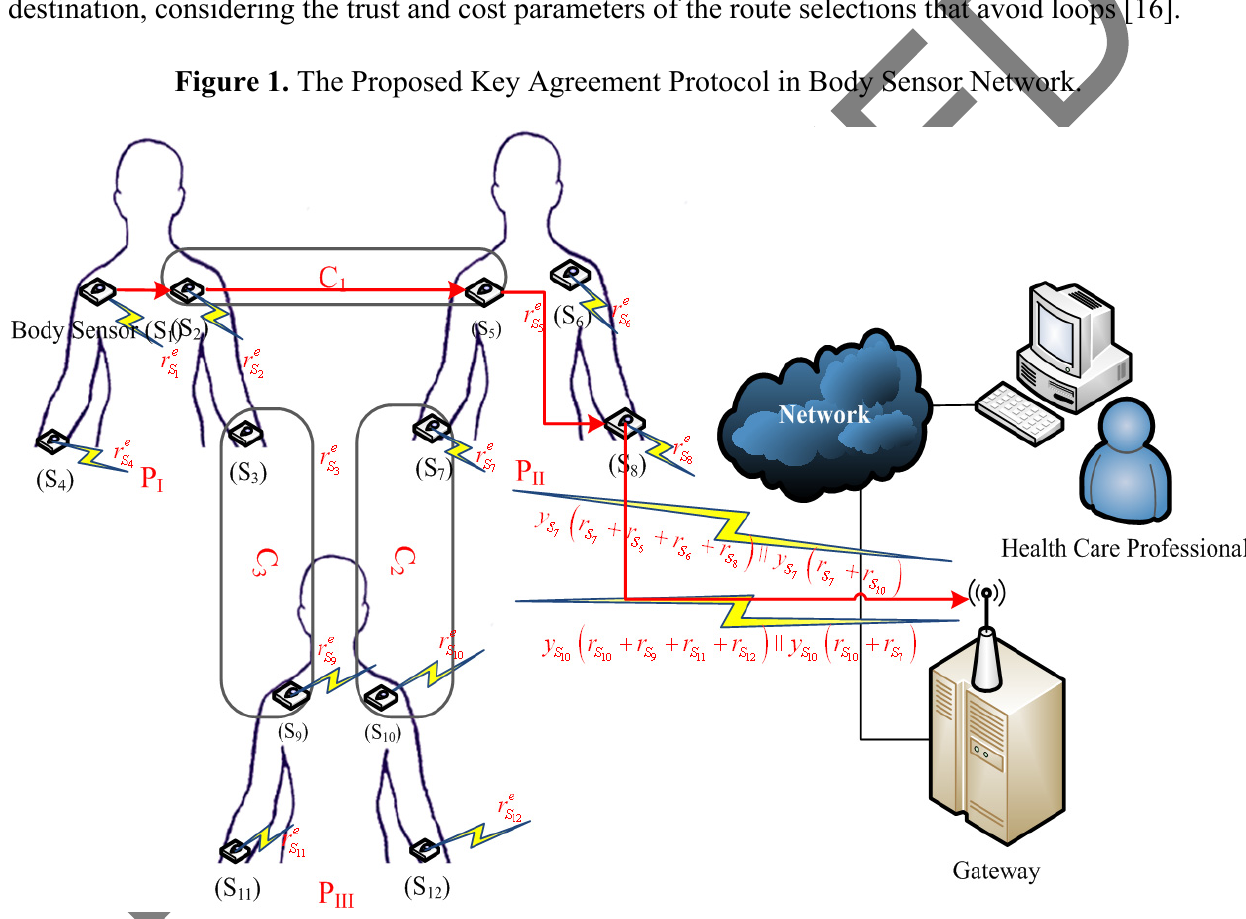
Figure 1. The Proposed Key Agreement Protocol in Body Sensor